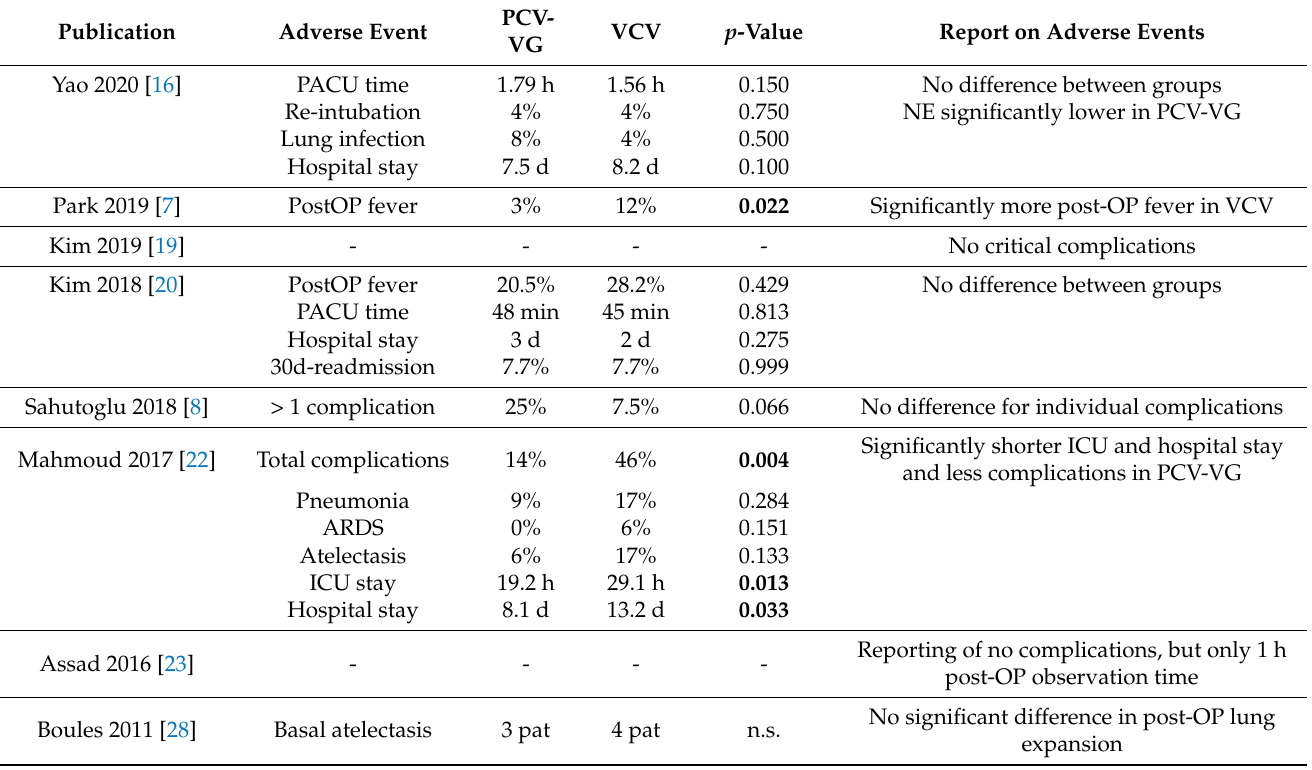
Table 3. Adverse events and additional outcome